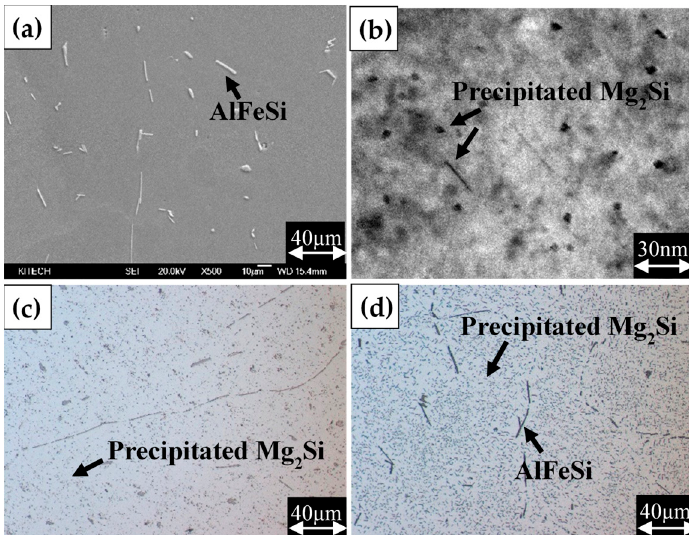
Figure 6. The precipitation of Mg 2 Si phase in Al-1.9Mg 2 Si alloy: ( a ) scanning electron microscope (SEM ) photograph after aging treatment at 180 °C for 5 h; ( b ) transmission electron microscope (TEM) photograph after aging treatment at 180 °C for 5 h; ( c ) optical microscope (OM) photograph after aging treatment at 240 °C for 5 h; and ( d ) OM photograph after aging treatment at 340 °C for 5 h.